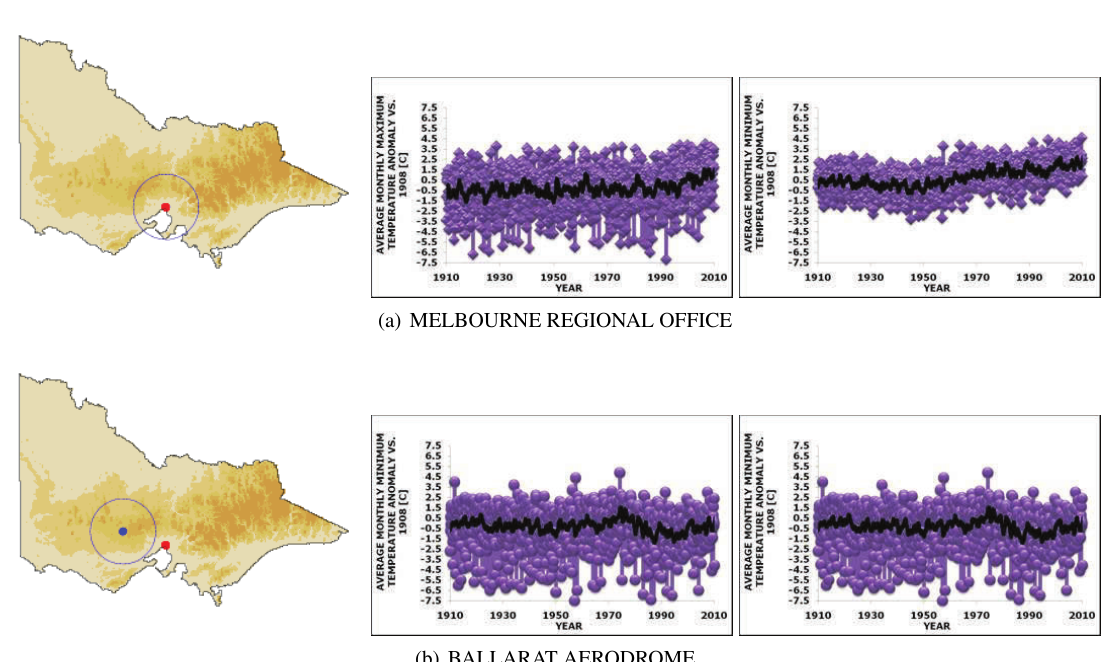
Figure 5. Average monthly maximum and minimum temperature anomalies vs. 1908 values for Melbourne and